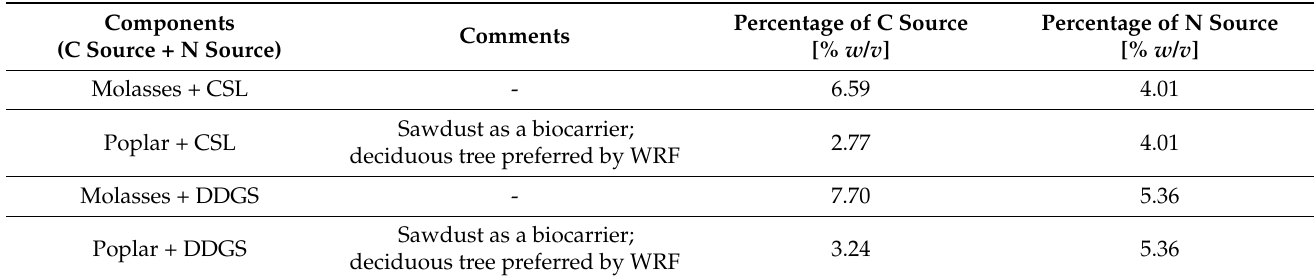
Table 2. Two-component media selected for further